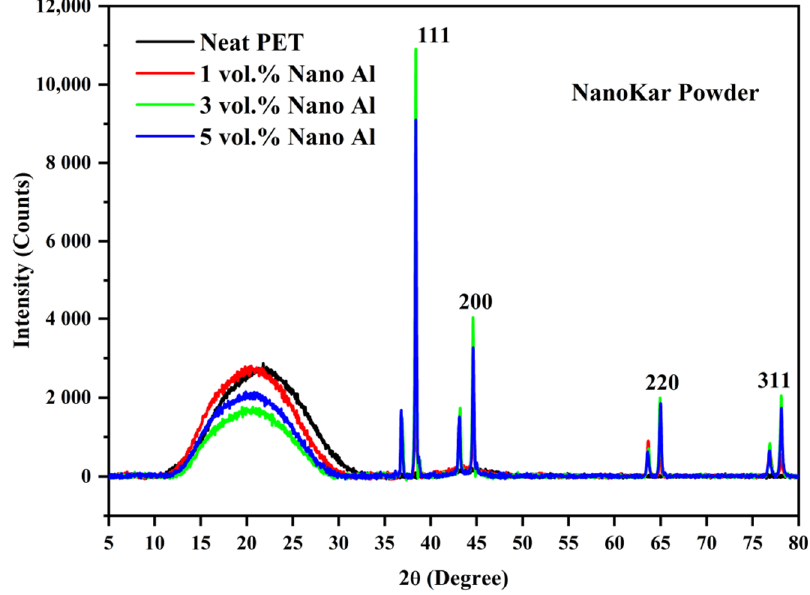
Figure 5. X-ray Di ff ractograms of the nano-Al 2 / amorphous PET composites. The broad peak at 2 θ Figure 5. X-ray Diffractograms of the nano-Al 2/amorphous PET composites. The broad peak at 2θ values between 11 ◦ and 33 ◦ confims the PET is in an amorphous values between 11 and 33°confims the PET is in an amorphous state.